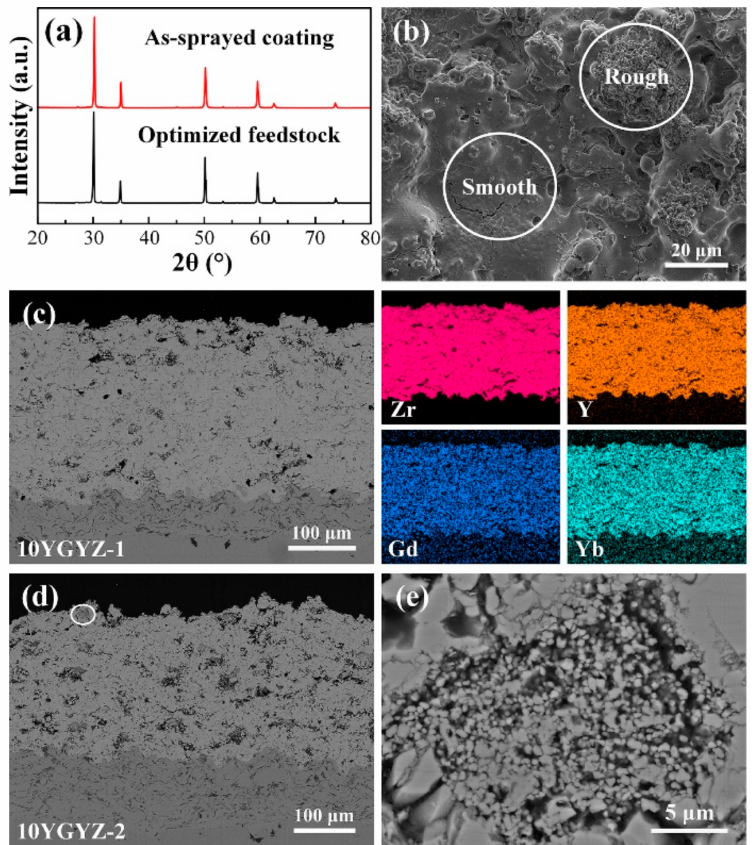
Figure 9. XRD patterns of optimized 10YGYZ feedstock and as-sprayed 10YGYZ coating ( a ), surface morphology of 10YGYZ-1 coating ( b ), cross-sectional microstructures of 10YGYZ-1 coating ( c ), with corresponding EDS mapping results of Zr, Y, Gd and Yb, and 10YGYZ-2 coating ( d ). An enlarged image of the marked region in ( d ) is also provided ( e